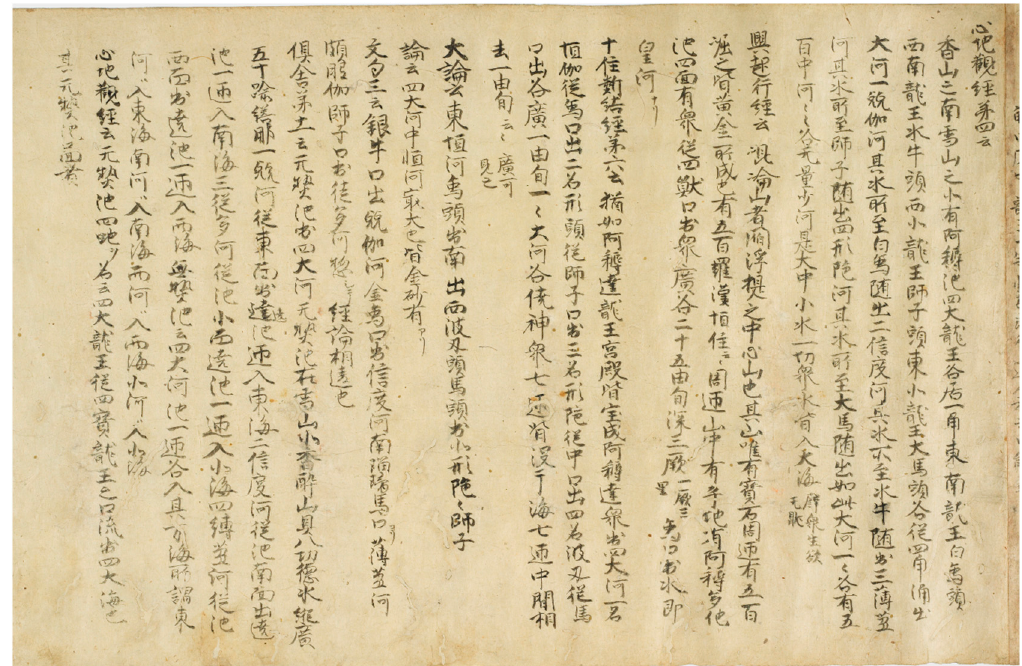
Figure 2. Passages on the Anavatapta Lake in the Harvard scroll. Section from a Buddhist Cosmology ( Nihon koku narabini Shumi shoten zu ) with text copied by Monk Ry¯ui; Harvard Art Museums / Arthur M. Sackler Museum, Gift of the Hofer Collection of the Printed and Graphic; © President and Fellows